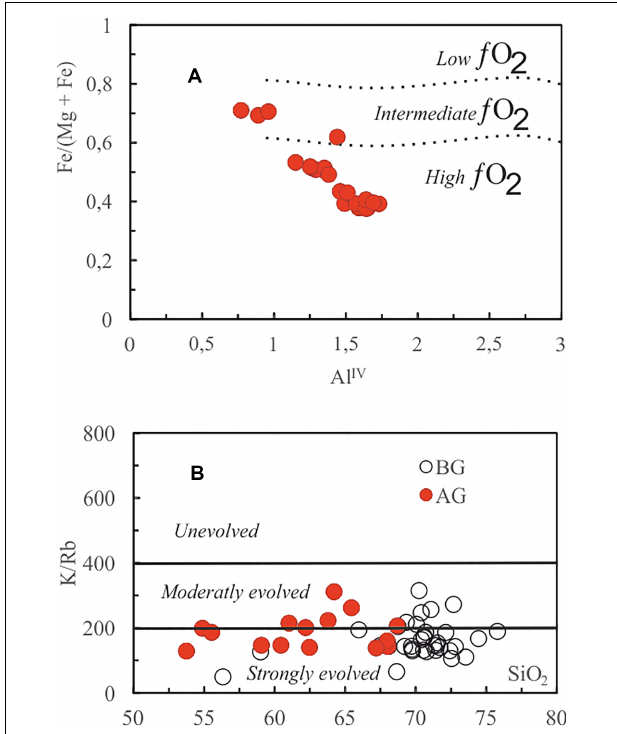
FIGURE 8 | (A) Al IV values vs. Fe/(Fe + Mg) ratios of amphiboles from the amphibole granites. Low, intermediate, and high oxygen fugacity ( f O 2 ) fields are after Anderson and Smith (1995). (B) K/Rb vs. SiO 2 diagram showing moderately to strongly evolved character of Batié granites after Blevin